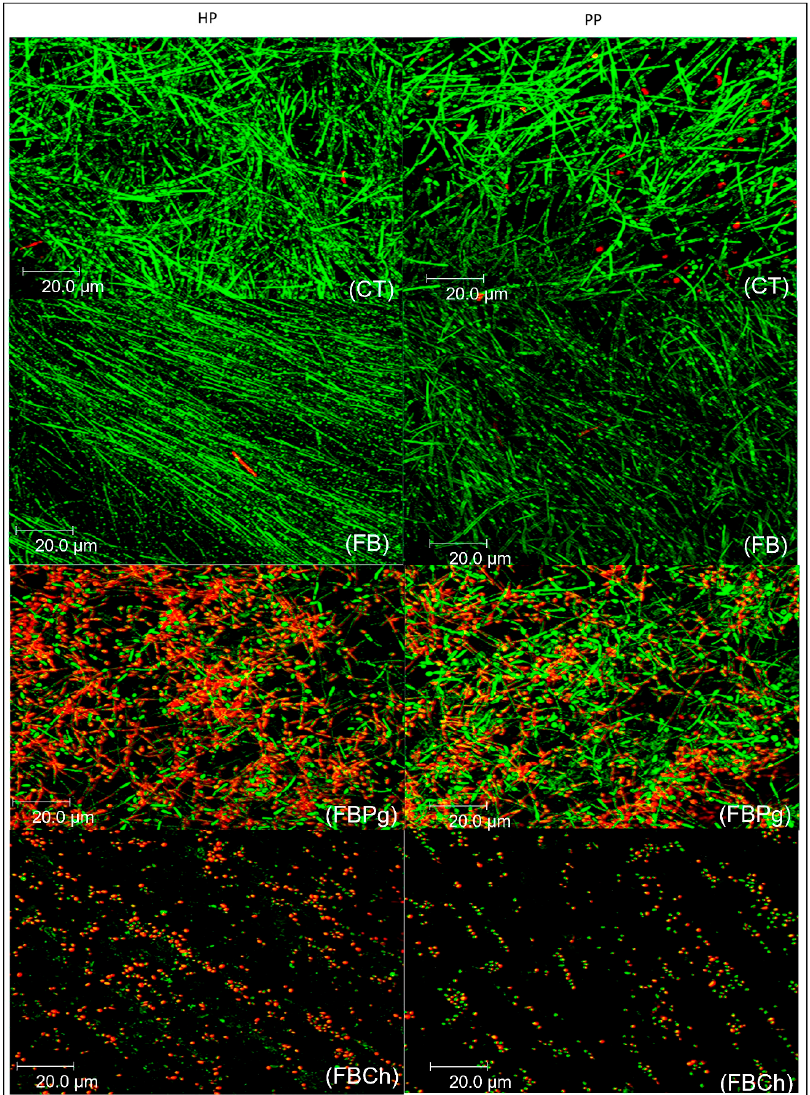
Figure 1. Confocal images of C. albicans biofilms developed on heat-polymerized (HP) and pre-pol ymerized (PP) surfaces after 24 h of incubation. CT: control group; FB: Fibrin biopolymer; FBPg: P. granatum incorporated in fibrin biopolymer; FBCh: Chlorhexidine incorporated in fibrin biopolymer. After 48 h of incubation, in the control (Figure 2) and FB groups (Figure 2), a large amount of yeast and hyphae were evident, ratifying the quantitative CFU and VC find- ings. Some C. albicans blastopores and yeasts were noted in biofilms treated with FBPg